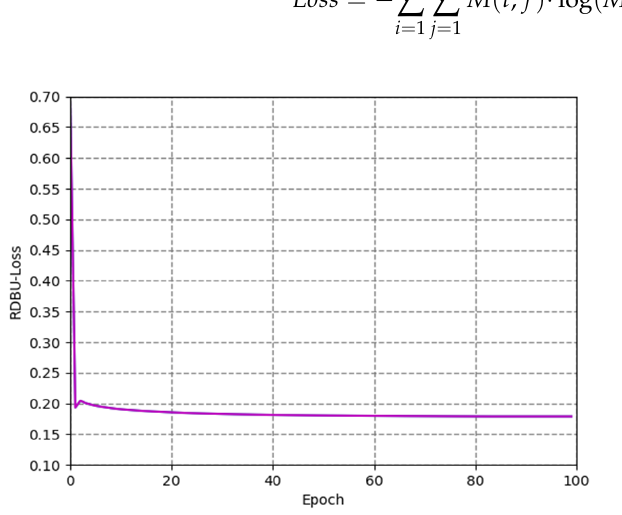
Figure 6. Decline curve of the loss